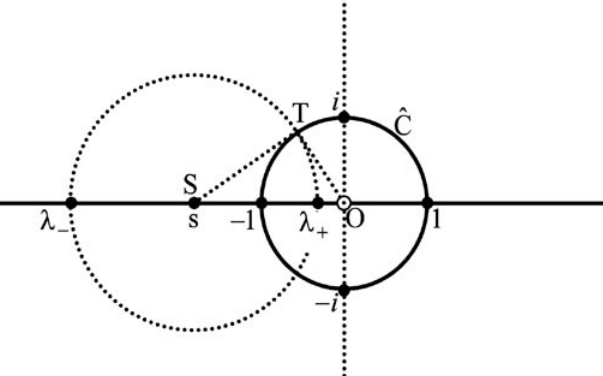
Figure 2 Constructing the eigenvalues for a particular semi- trace s < –1. ST is tangent to the unit circle C at T. λ – and λ+ are at the intersection of the real line and the circle with centre S and radius ST.